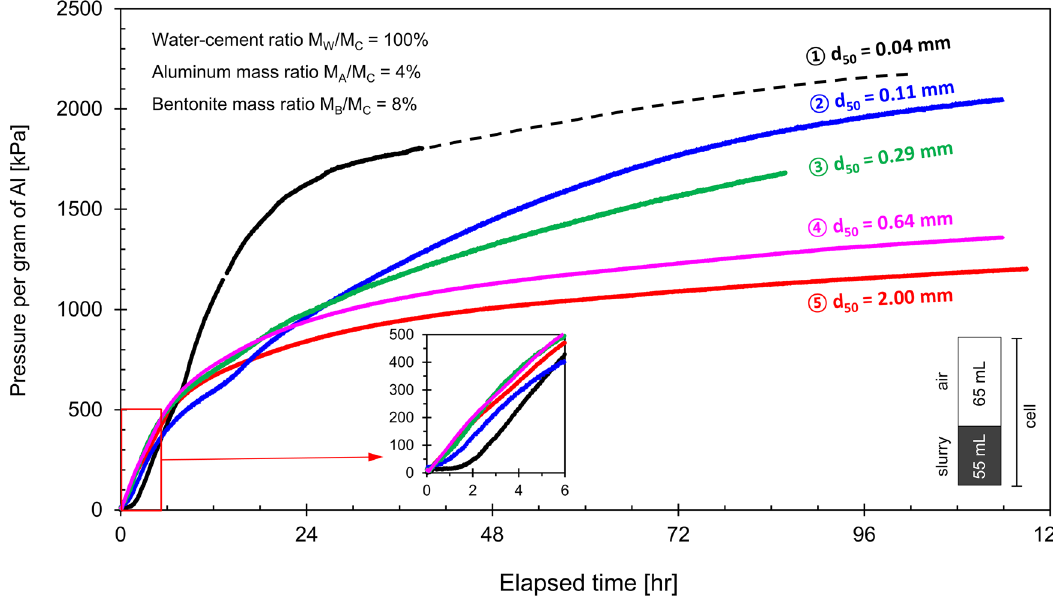
Figure 4. Pressure per gram of pure aluminum for the cement–water–aluminum specimens prepared with five different aluminum chip size d 50